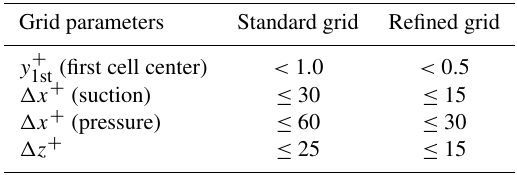
Table 2. Parameters for the grid convergence study. Grid parameters Standard grid Refined